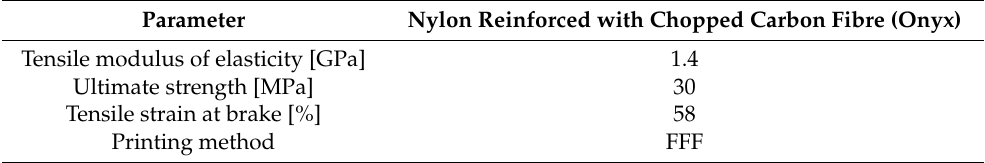
Figure 2. Perpendicular ply sequence ( left ); laminas orientation ( middle ); filament reinforced with chopped carbon fibre ( right ).